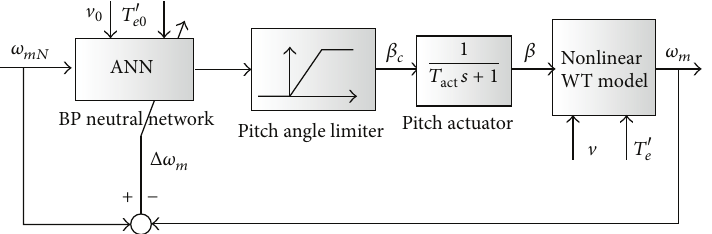
Figure 9: System frame of model independent NCNM scheme.